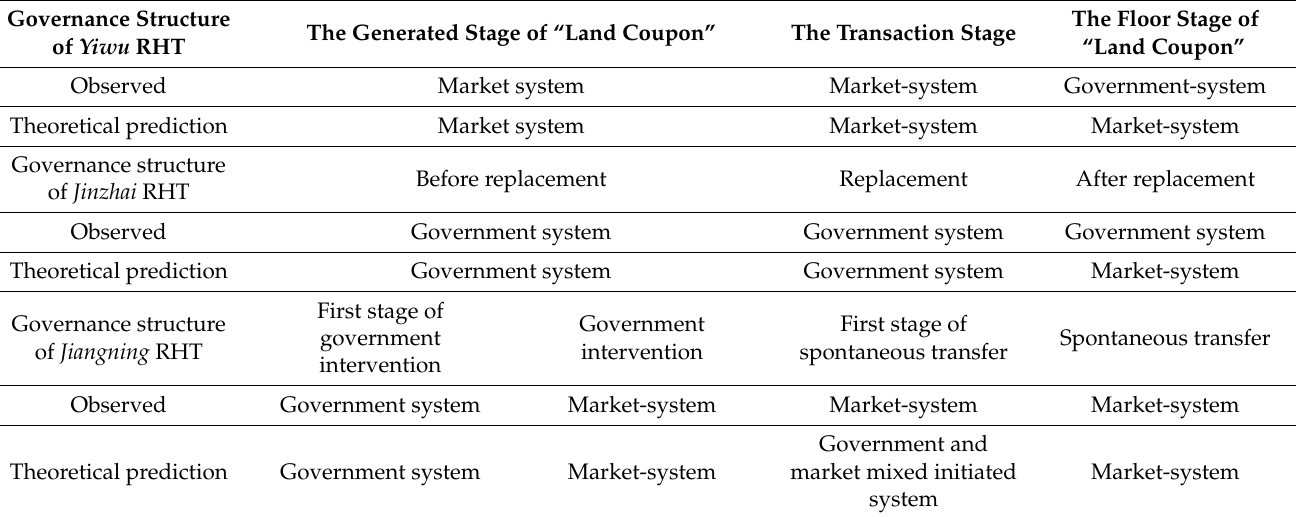
Table 3. Practical and matching governance structures in the different